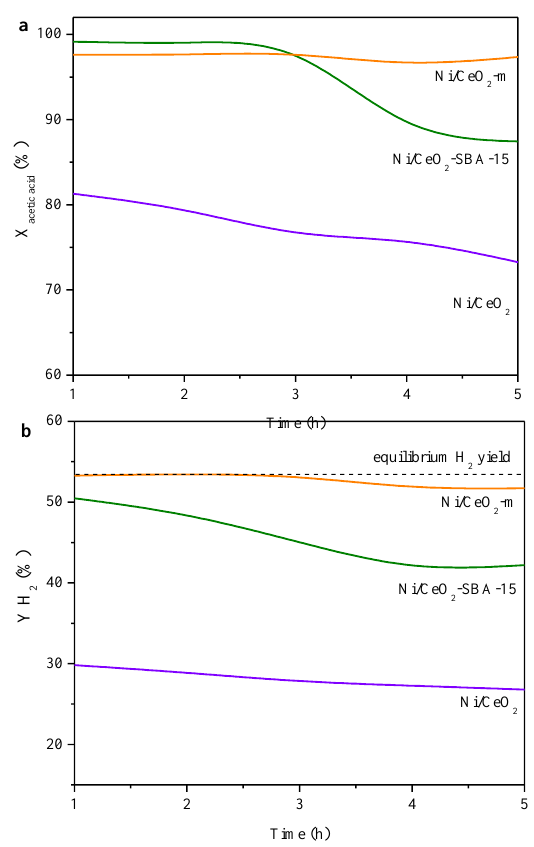
Figure 7. Catalytic results of Ni-supported catalysts at 500 ◦ C using an O 2 /AcOH molar ratio of 0.075: ( a ) acetic acid conversion; ( b ) hydrogen yield.